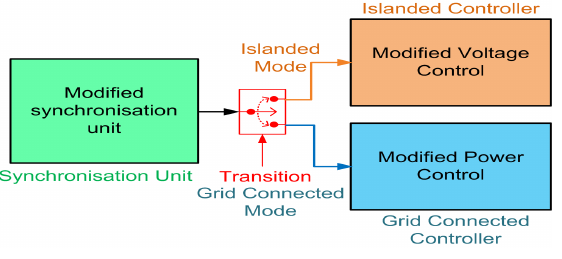
Figure 3. Modified control scheme for